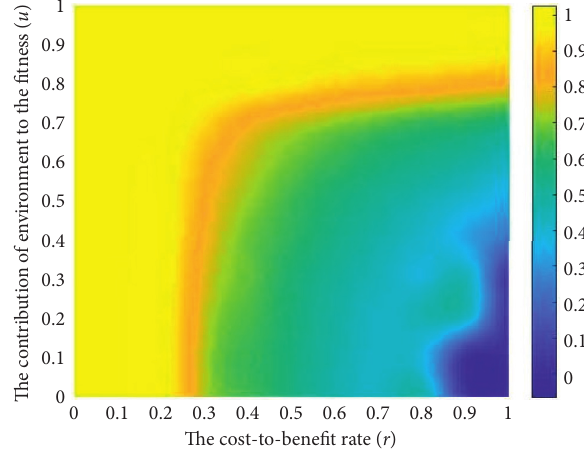
Figure 5: The colour-coded (see the bar on the right) density of cooperation ρ c on the u − b parameter plane. The depicted are obtained in PDG for α � 2. The yellow shading corresponds to the higher stationary density of cooperators at each particular com- bination of u and b . It can be observed that u promotes cooperation better than the b .